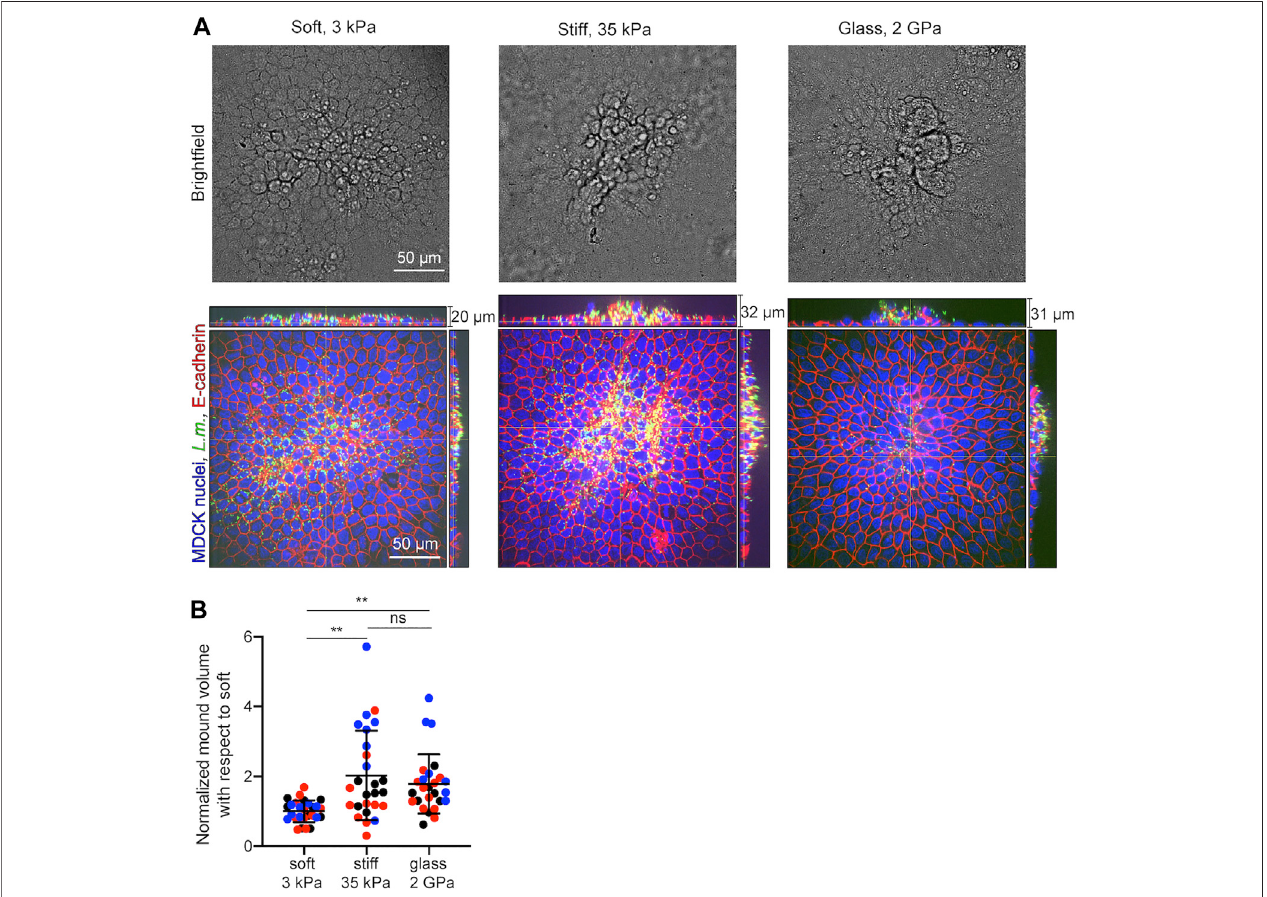
FIGURE 7 | In vitro infection experiments validate the computational fi nding of increased infection mounding when cells reside on stiffer matrices. (A) Representativebright fi eldimage(toprow)andorthogonalviews(bottomrow)of L.m. fl uorescenceingreen,E-cadherininredandMDCKnucleiinblueforcellsoriginated from a L.m. -infected well with the fi eld of view shown focused around and infection focus at 24 hpi. MDCK cells resided on soft 3 kPa hydrogels (left), or stiff 35 kPa hydrogels (middle), oronglass coverslips(right). (B) Barplotsofrelative L.m. -infectionmoundvolume at24 hpiforMDCK cellsresiding onsoft3 kPahydrogels,on stiff35 kPahydrogels,oronglass.Foreachof N =3independentexperiments(shownindifferentcolor),valueshavebeennormalizedrelativetothemeanmoundvolume of cells residing on a soft 3 kPa matrix and each circle corresponds to a distinct mound (N = 26 or 27 mound volumes quanti fi ed for each condition). (mean ± SD, Wilcoxon Rank Sum test: **: p < 0.01, ns: non-signi fi